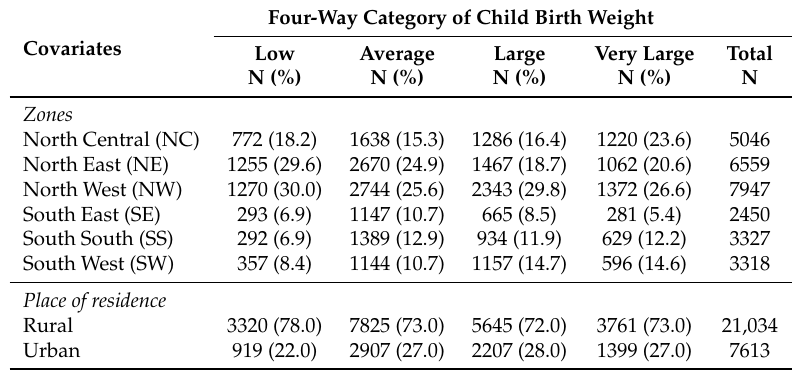
Table 3. Descriptive summary of the socio-demographic characteristics (covariates) used in the model by four-way category of birth size in 2008